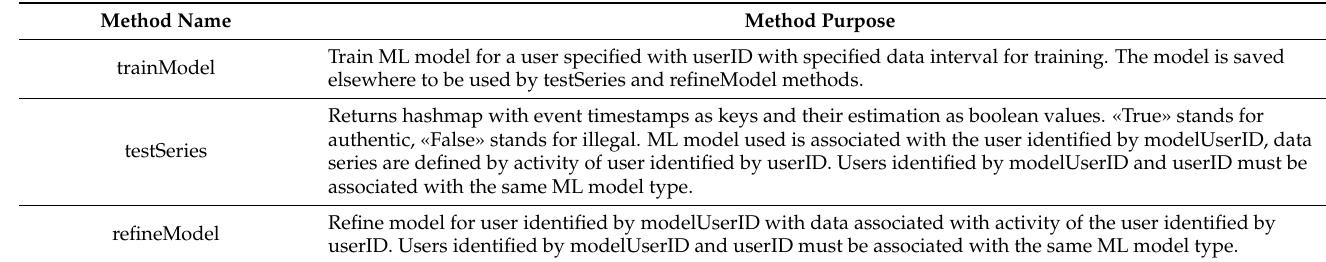
Table A9. Methods of IAuthenticityModel